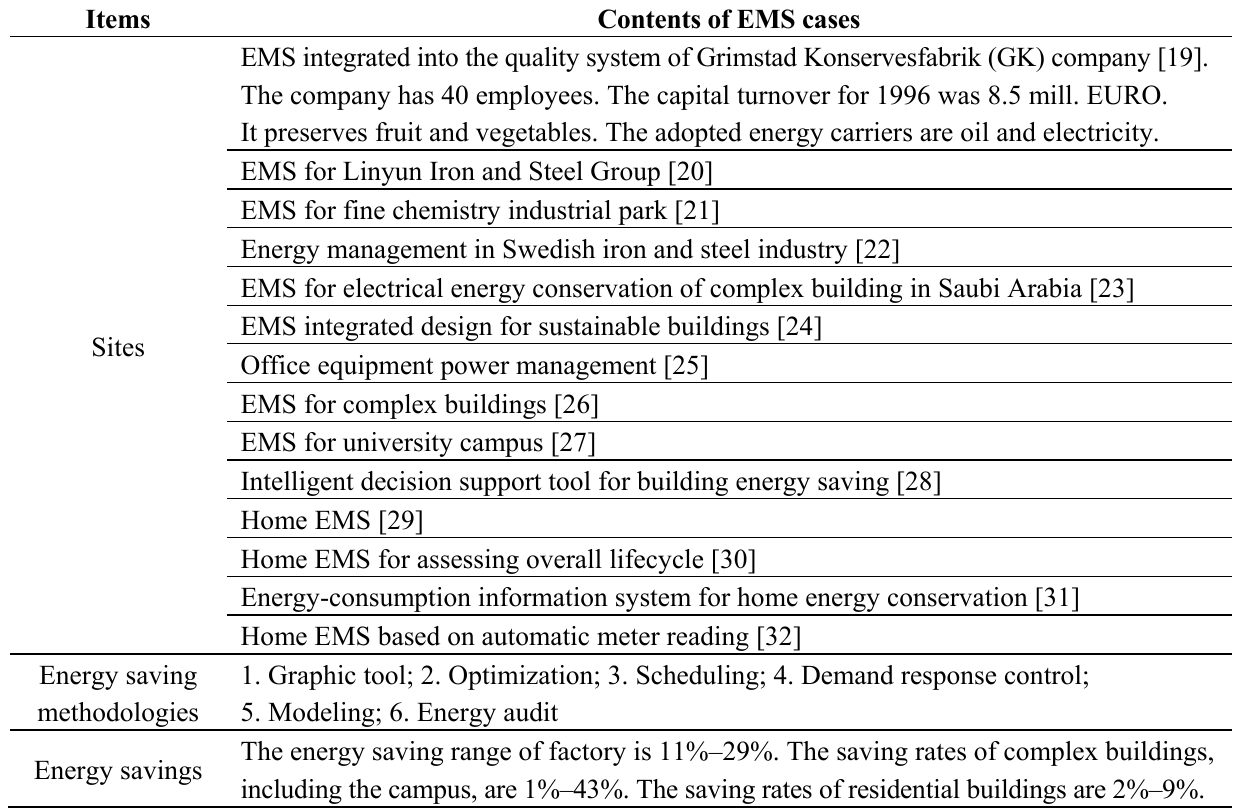
Table 2. The selected EMS cases of whole